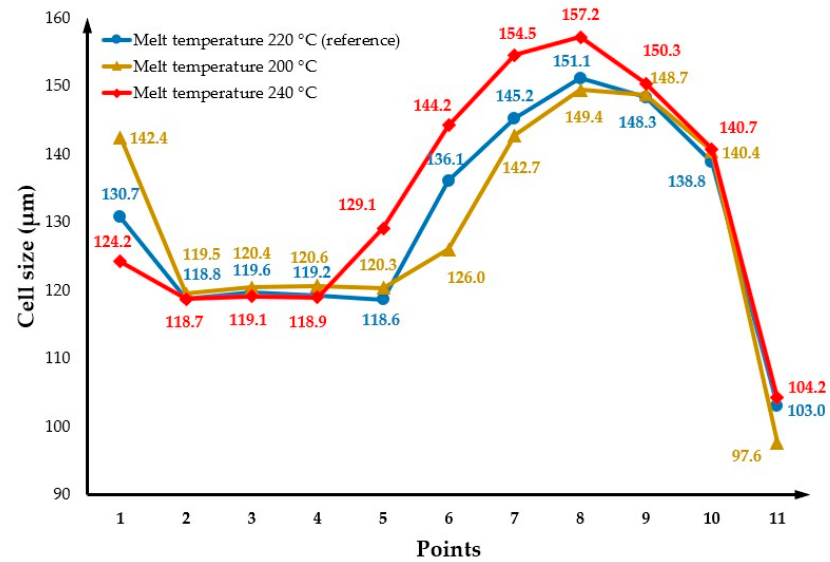
Figure 14. Cross-section variation in cell size as a function of melt temperature.